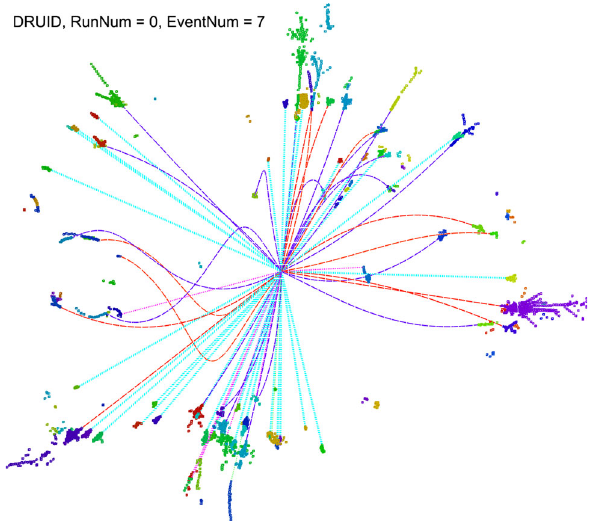
Fig. 4 The display of a reconstructed WW event. This event has 82 final state particles whose energy exceed 0.5GeV, reconstructed by Arbor. The charged particles are represented by the curves (color repre- sents particle charge) associated with calorimeter clusters. The photons are displayed as cyan straight lines associated with calorimeter clusters